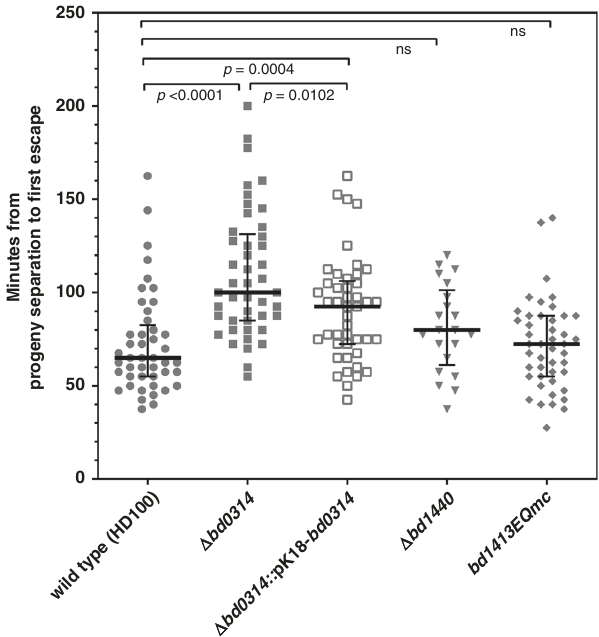
Fig. 2 Δ bd0314 shows a delayed prey exit phenotype. Comparison of time required from progeny separation to the fi rst exit of B. bacteriovorus HD100 wild type vs. Dsl- family mutant strains ( Δ bd0314 , Δ bd1440, and bd1413EQmc ) and complemented strain ( Δ bd0314 ::pK18- bd0314 ) from prey cell bdelloplast remnants monitored by epi fl uorescence time-lapse microscopy. Bdelloplasts were placed on a 1% agarose slide ~3h post-infection of E. coli S17-1::pMAL- p2_mCherry (generating fl uorescent prey periplasm and cytoplasm) and observed for another 4h 40min to determine backlit predator progeny septation and any exit 34 . Median values and interquartile range are shown as black lines. Data originate from at least two independent biological replicates ( n = 45 for each strain, except for Δ bd1440 , where n = 21). The two-tailed p - values are derived from the Mann – Whitney test (ns non-signi fi cant, p -values are presented in the fi